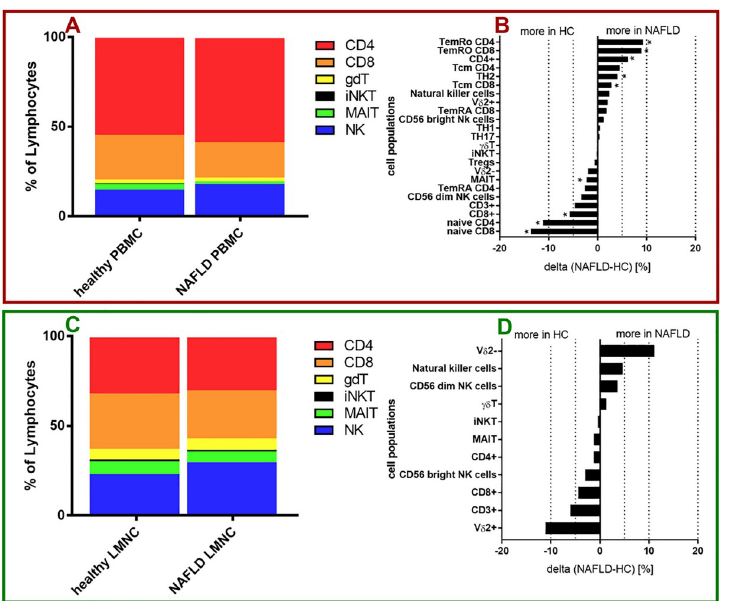
Fig 1. Immune cell composition in NAFLD. (A, C) Composition of infiltrating immune cells in PBMC (A) and liver samples (C) of healthy controls as well as NAFLD patients summarized from calculated mean values of each patient group. (B, D) Changes of immune cell composition between NAFLD patients and healthy controls in PBMC samples (B) and liver samples (D). (red Box) PBMC data. (green Box) liver data. (B,D) For comparisons Mann-Whitney test was used. � p <